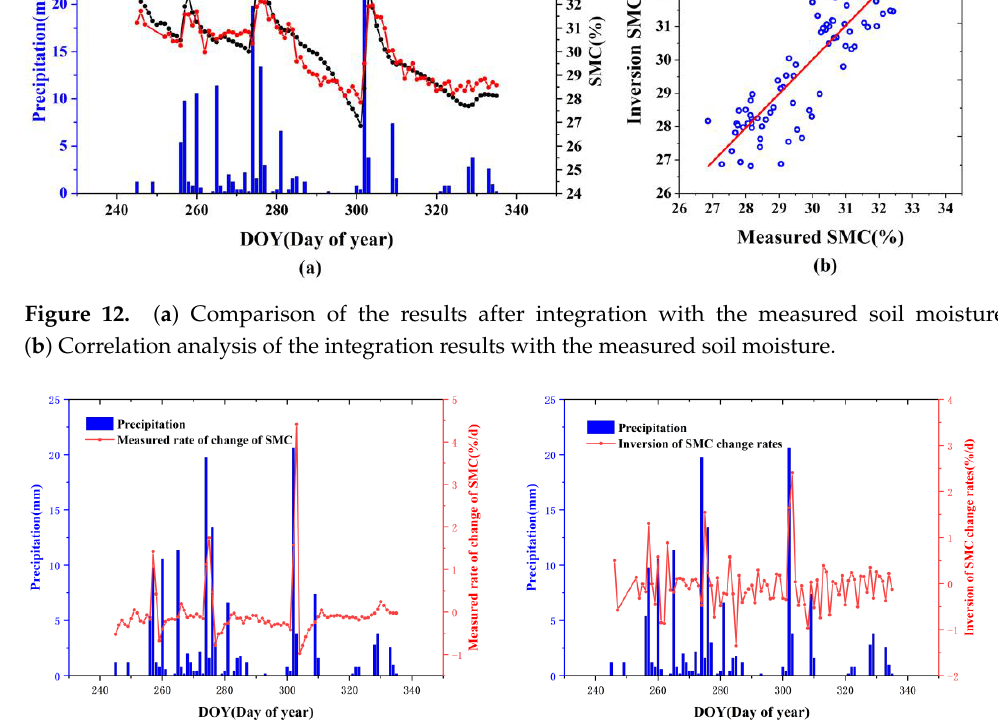
Figure 13. Relationship between rainfall and rate of change of ( a ) inverted soil moisture; ( b ) measured soil moisture.